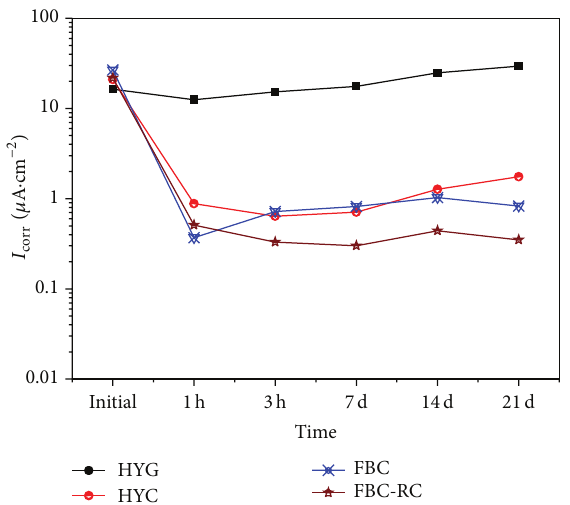
Figure 5: 𝐼 plots of electrodes coated with four kinds of coating corr in chloride solution.